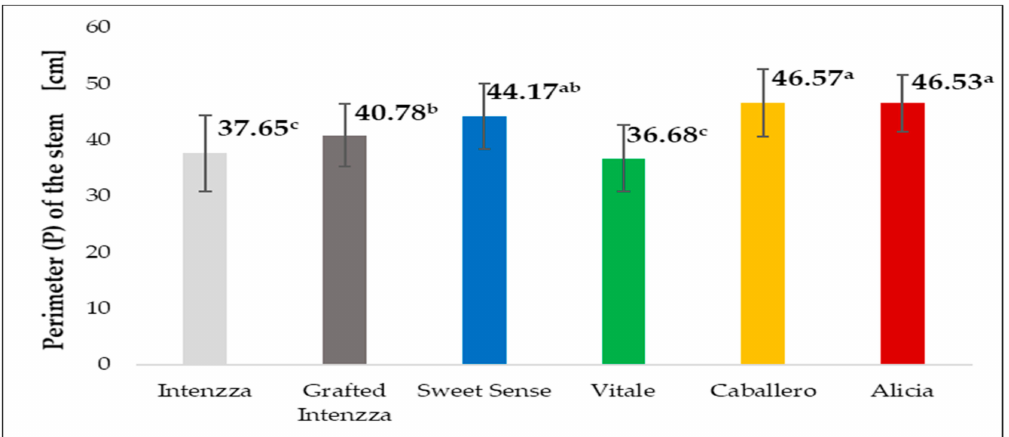
Figure 9. Perimeter (P) of the stem for the five cultivars of papaya planted under greenhouse. Di ff erent letters mean significant di ff erences, at p -value <